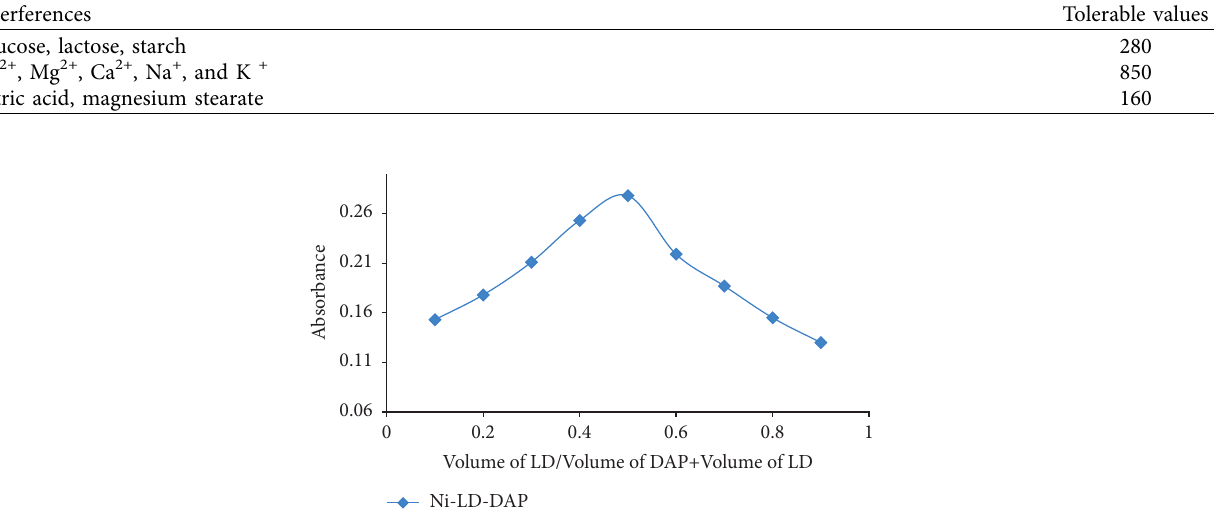
Figure 8: Stoichiometry of the reaction of the proposed method of LD determination using the ternary complexation procedure. Table 7: Analytical results of LD in pure form and pharmaceutical preparations determined by spectrophotometry using the ternary complexation